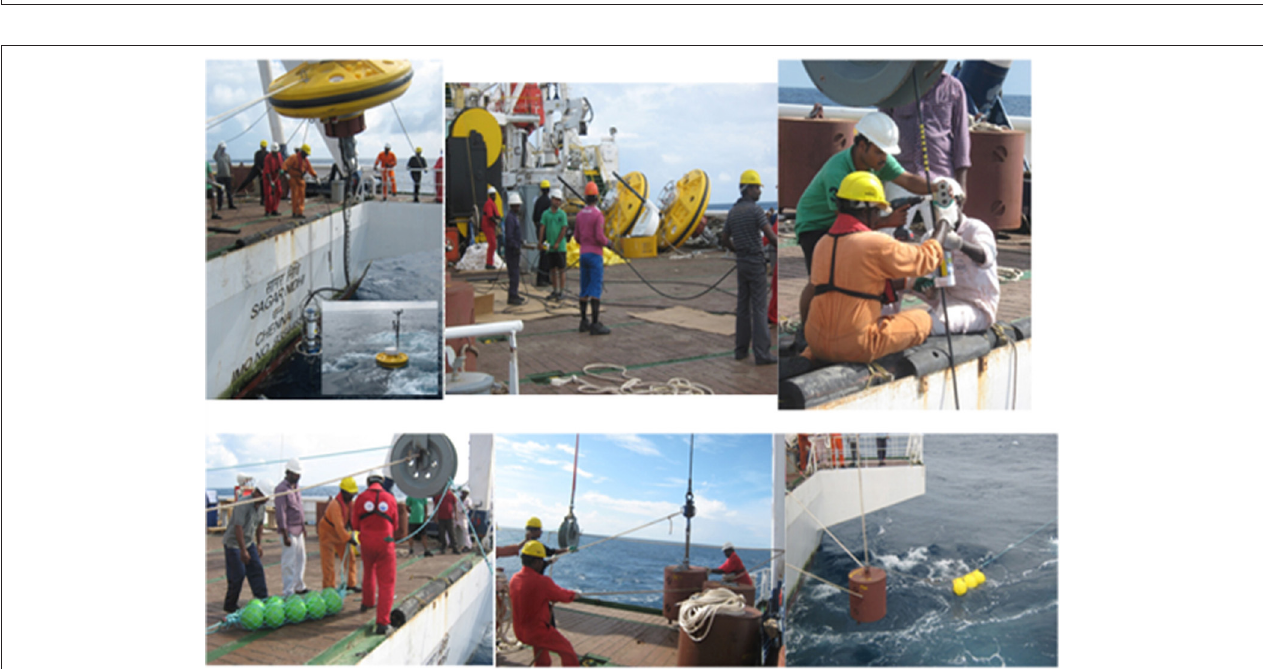
FIGURE 11 | Deployment of the buoy